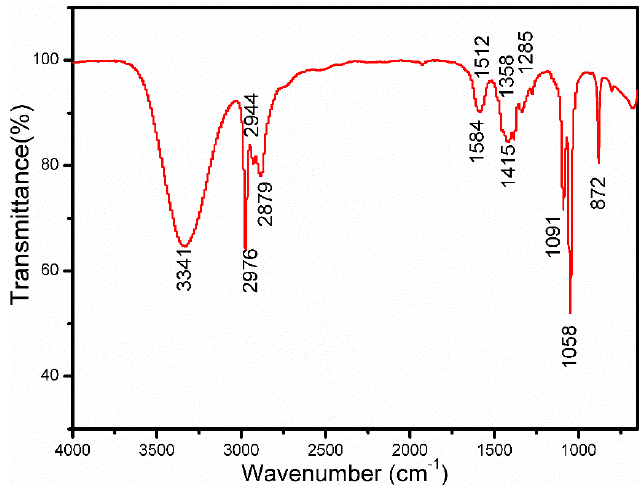
Figure 3. FTIR spectra of the ZnO sol with PEG1000.